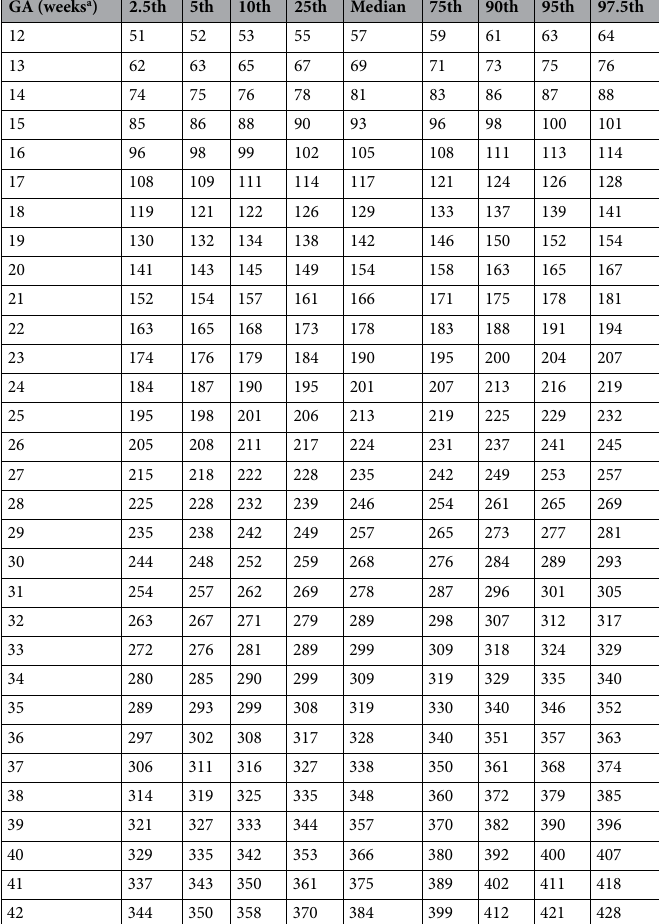
Table 9. Estimated abdominal circumference (AC) in mm by gestational age (GA) for males and females, percentiles. a GA expressed as completed gestational weeks, e.g. 12 weeks corresponds to 12 + 0 weeks or 84 gestational